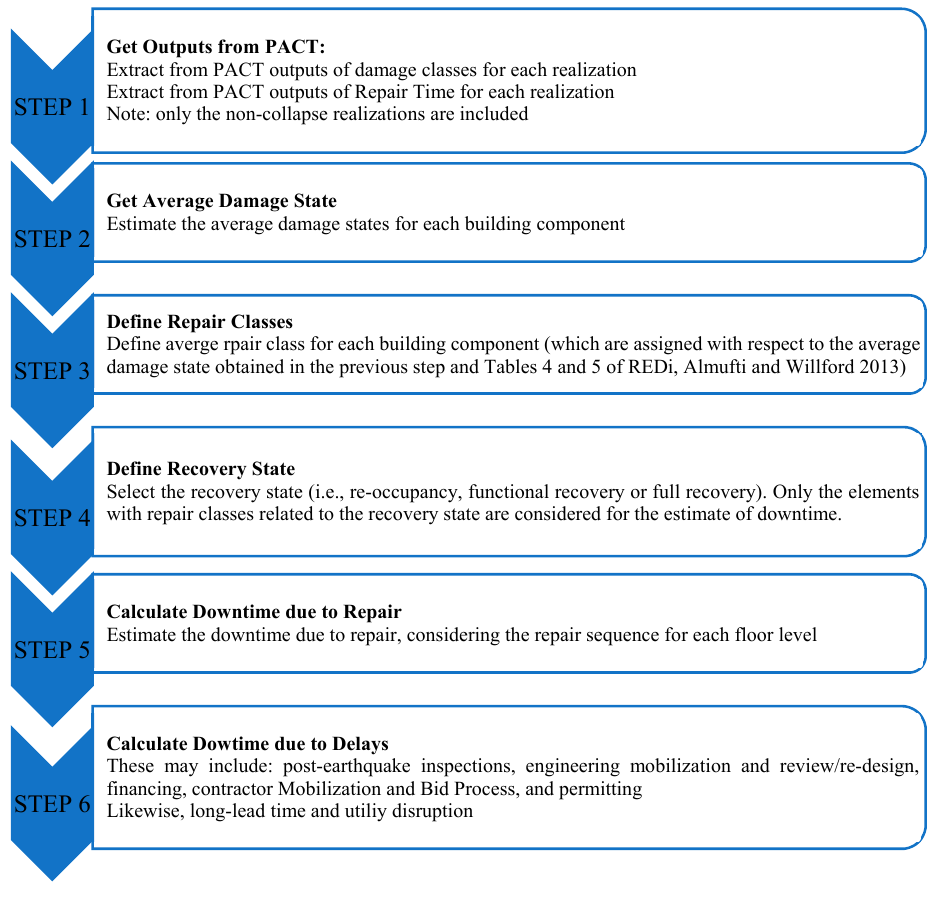
Figure 5. Example of repair sequence, considering delays and utility disruption, adapted from [1]. Overall, the REDi guidelines provide a comprehensive framework to evaluate differ- ent resilience parameters. Even though the framework is challenging and time-consum- ing, due to the level of analysis to carry out and subsequent postprocessing of outputs, it yields relevant aspects, such as delays, total downtime, repair classes, and resilience cate- gory, among others, that can evaluate seismic resilience in a more precise way.